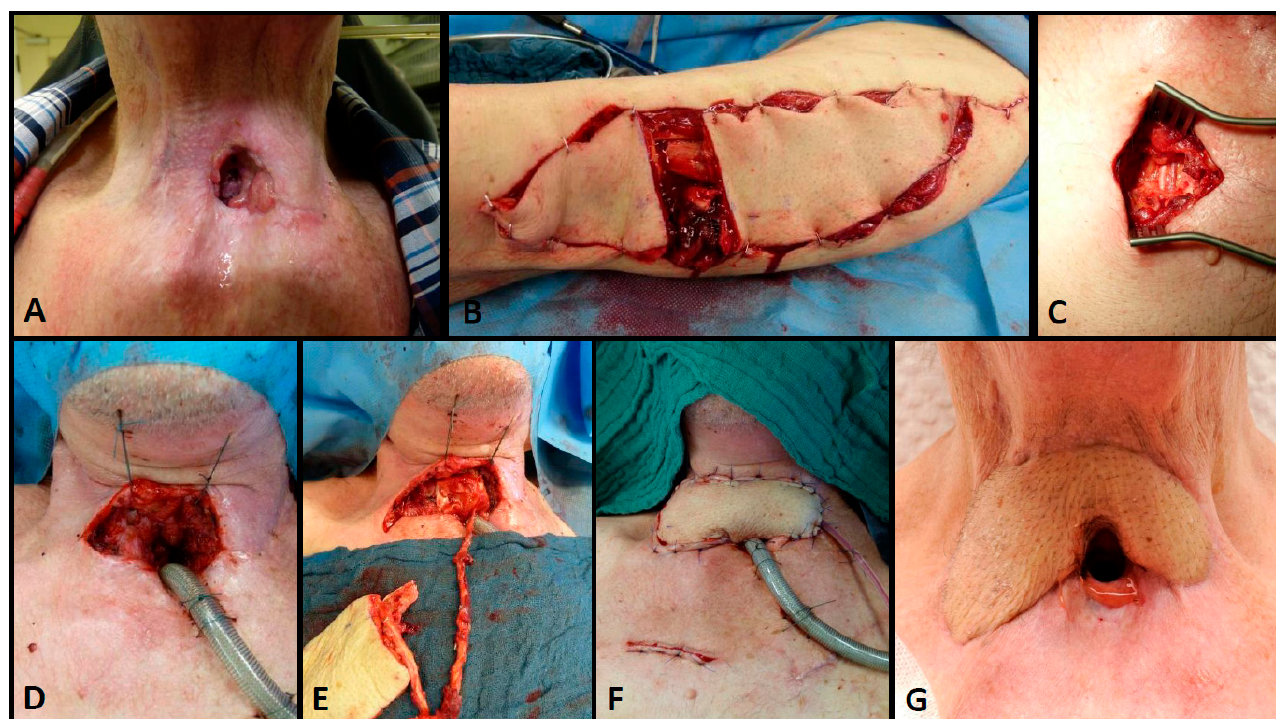
Figure 3. Seventy-four-year-old patient who had undergone laryngectomy, neck dissection and radiotherapy for laryngeal cancer. He was treated for an extrathoracic TEF ( A ) using a split anterolateral thigh (ALT) flap with two skin islands ( B ) that was anastomosed to the internal mammary vessels ( C ). One skin island was used for fistula closure ( D , E ) and the other to cover the skin defect cranial from a permanent tracheostomy ( F ). ( G ); long term result after 6 months.